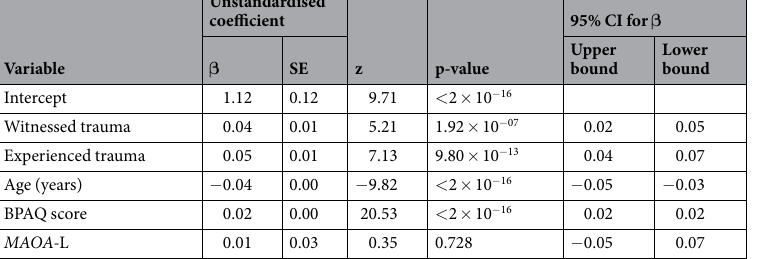
Table 3. Association between MAOA- uVNTR variant and appetitive aggression (AAS score), using additive genetic models. Abbreviations: β , estimated Poisson regression coefficients for the model; SE, standard error of the individual regression coefficients; z, z-test statistic; CI, confidence interval; BPAQ, Buss-Perry Aggression Questionnaire; MAOA , monoamine oxidase A; MAOA -L: low-expressing MAOA- uVNTR allele combination (2- and 3-repeat alleles). Hosmer-Lemeshow goodness-of-fit: χ 2 = − 4.95, df = 8, p-value = 1.